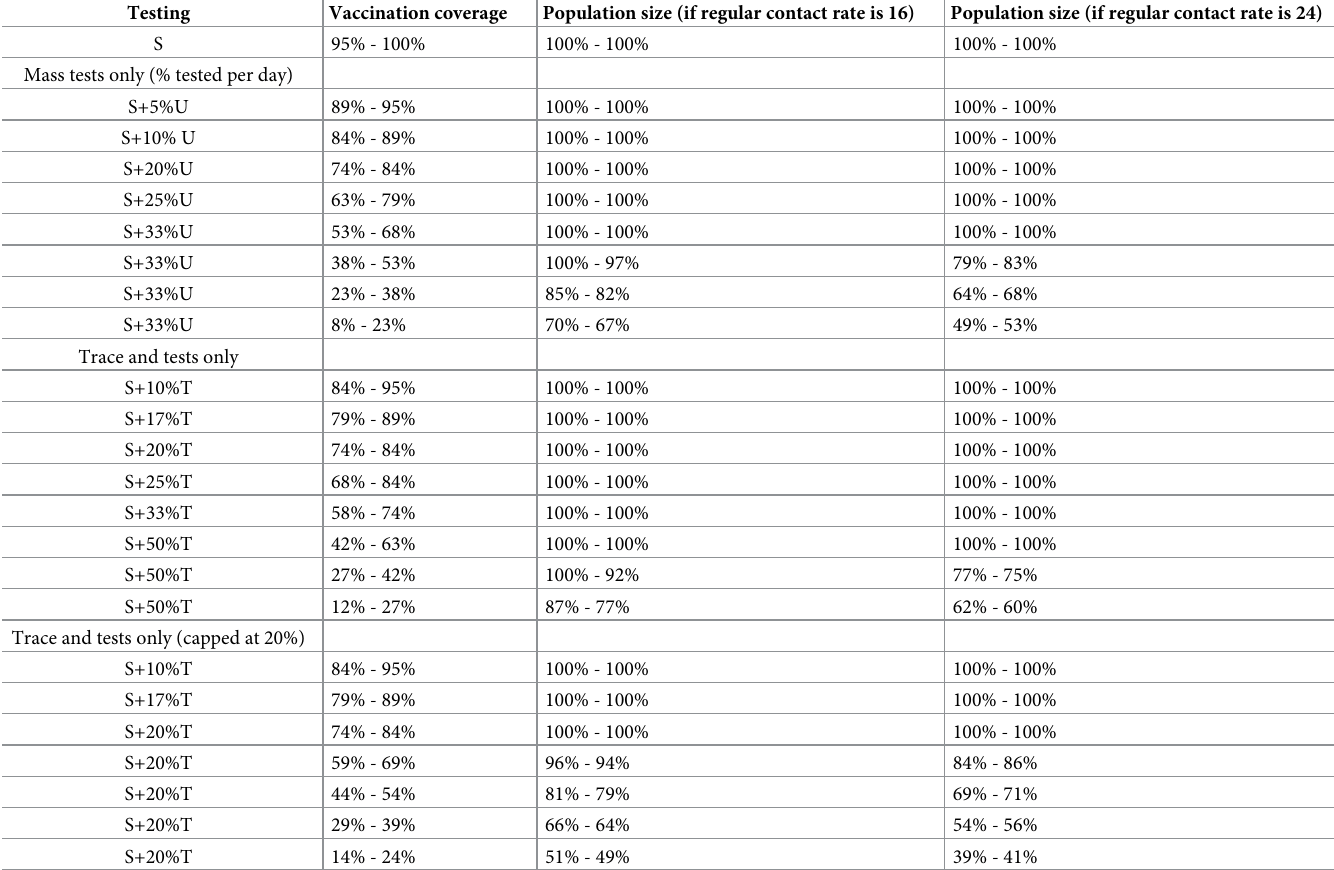
Table 2. Combinations of testing, vaccine coverage, and population size for effective control of a disease